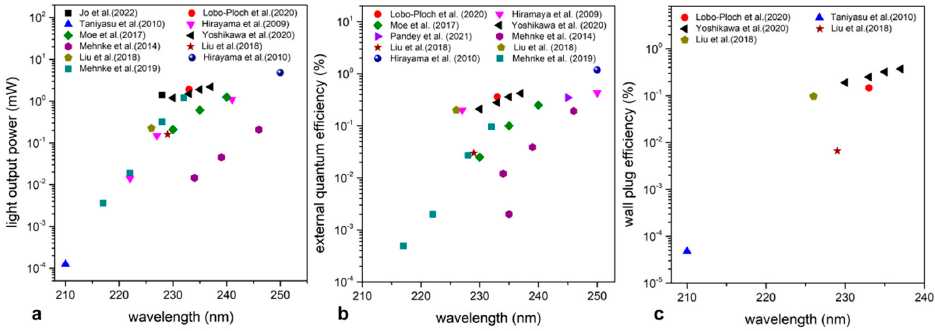
Figure 2. Summary of the reported ( a ) EQE, ( b ) LOP, and ( c ) WPE of 250 nm and sub-250 nm LEDs in dependence of emission wavelength in recent literature